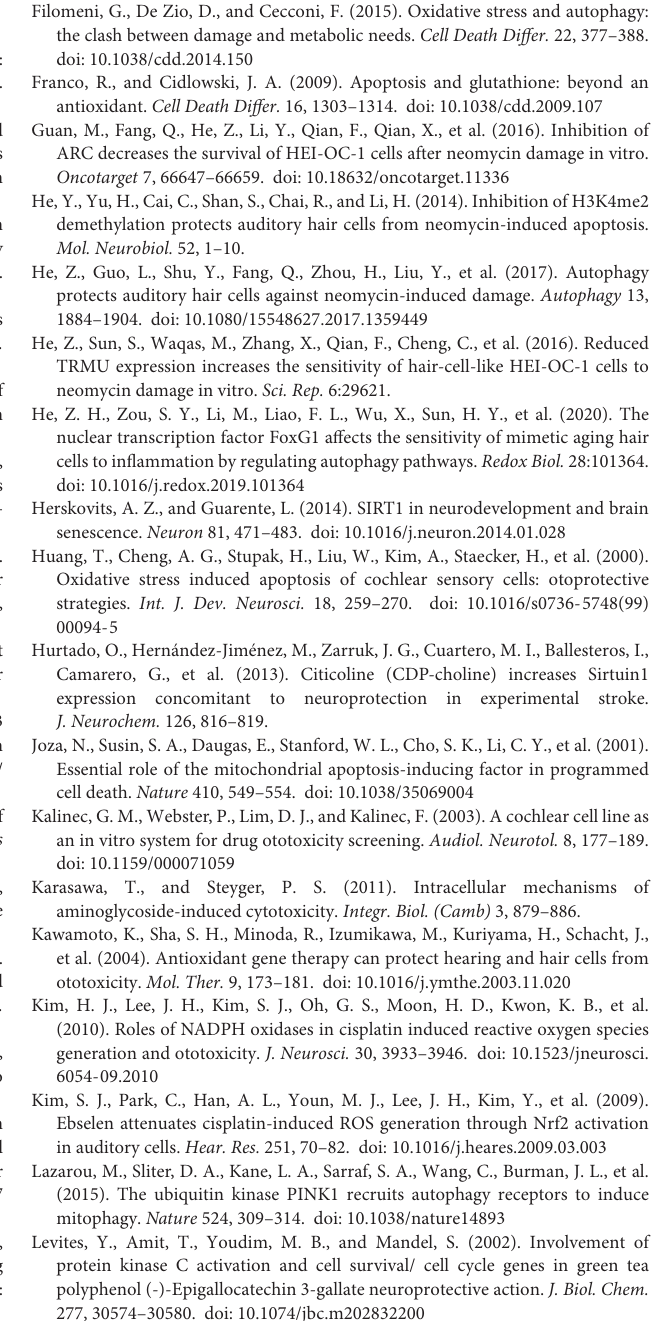
FIGURE S1 | Citicoline promotes HEI-OC1 cells survival after neomycin exposure. (A) The CCK-8 kit measured the cell viability after treatment with different neomycin concentrations (1–20 mM) for 24 h. (B) The cell viability was